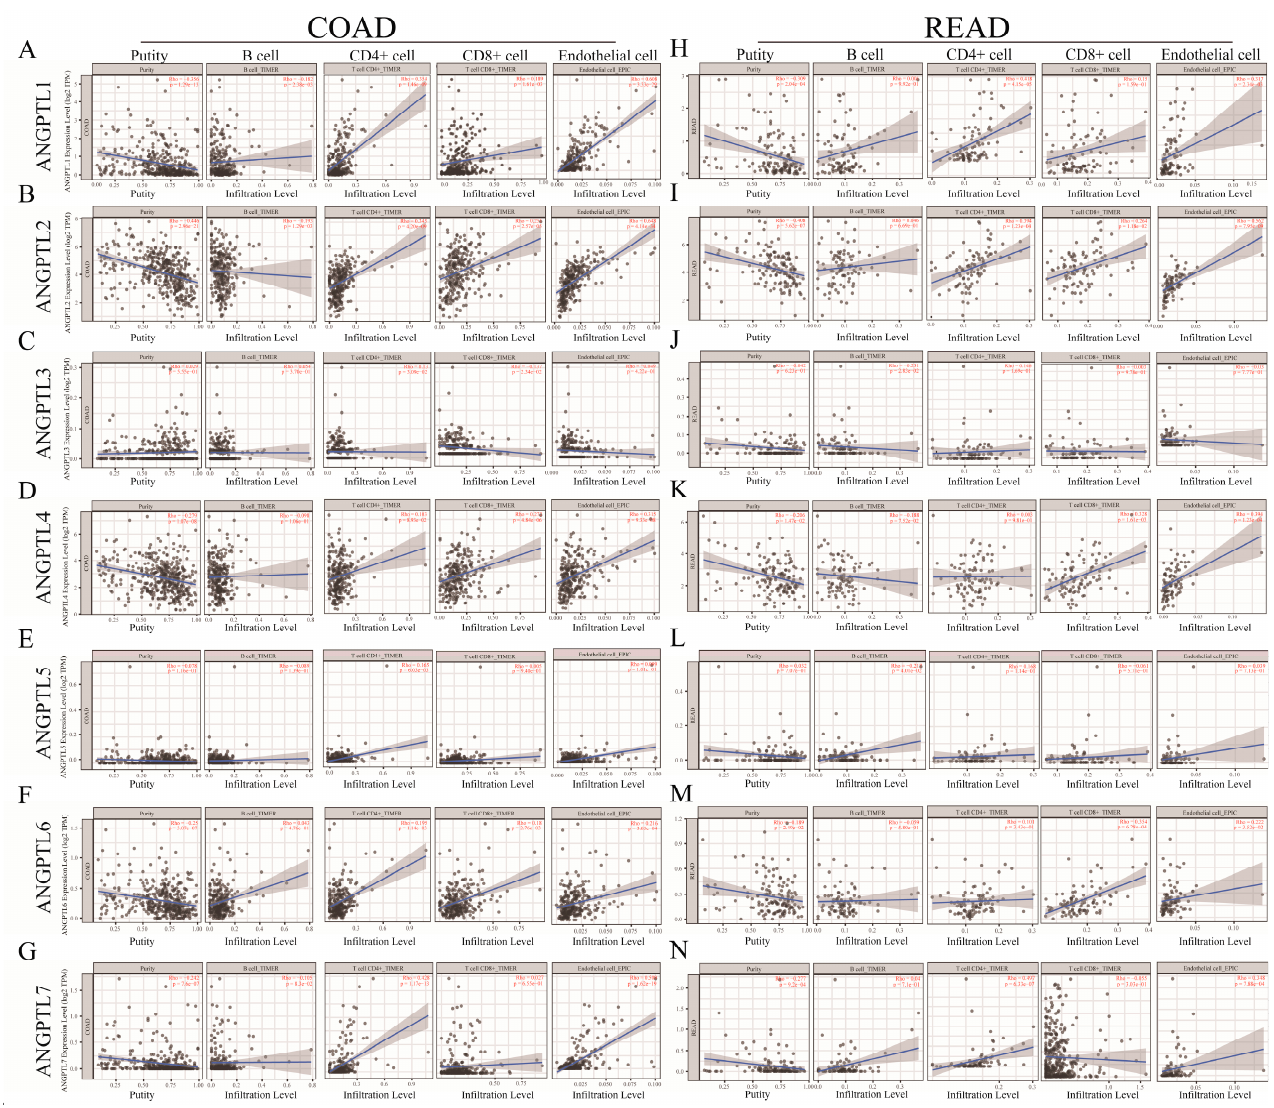
Figure 6. Correlations between seven ANGPTLs and immune cell infiltration in colon/rectal cancer (TIMER2.0). ( A – G ) Colon cancer. ( H – N ) Rectal cancer. Immune cells included B cells, CD4+ T cells, CD8+ T cells, and endothelial